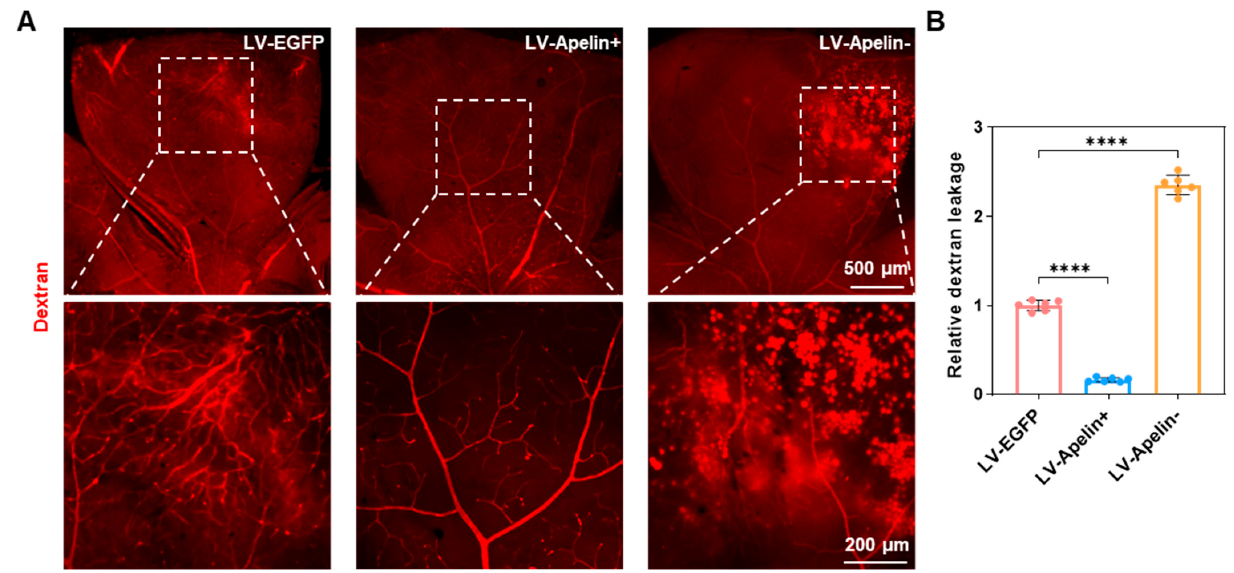
Figure 4 . Retinal leakage in DR mice treated with LV-EGFP, LV-Apelin+, or LV-Apelin − . ( A ) Representative dextran leakage images and ( B ) the quantification of dextran leakage revealed that the leakage of retinal vessels was moderate in the LV-EGFP group; however, it decreased in the LV-Apelin+ group and increased in the LV-Apelin − group. Data were expressed as mean ± SD. LV-Apelin+ versus LV-EGFP; LV-Apelin − versus LV-EGFP; **** p < 0.0001 (n = 6).